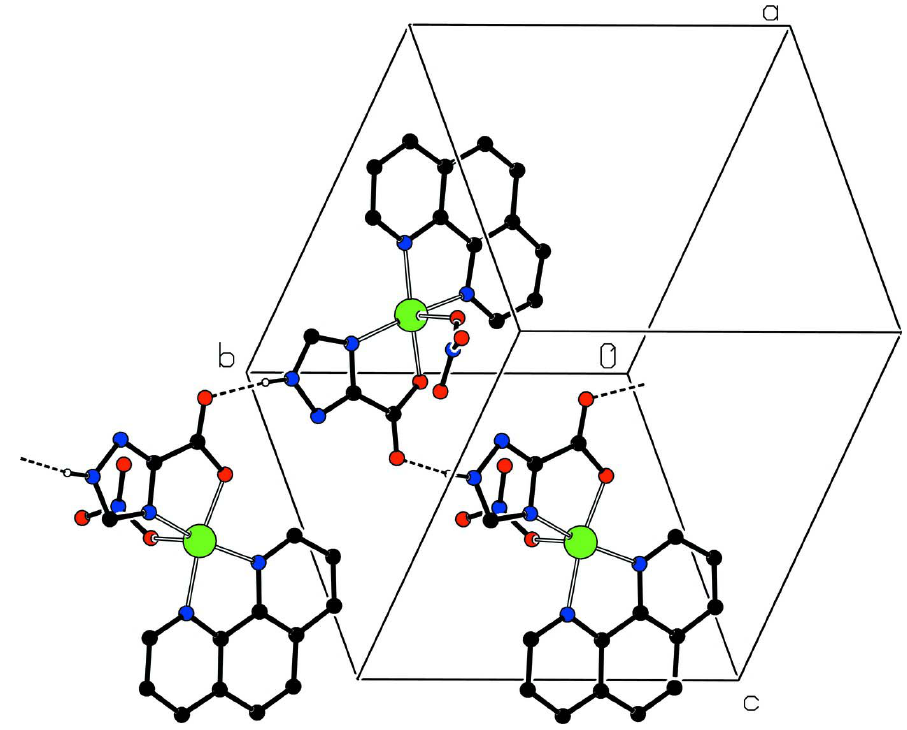
Figure 2 Part of the crystal structure of the title compound showing hydrogen bonds as dashed